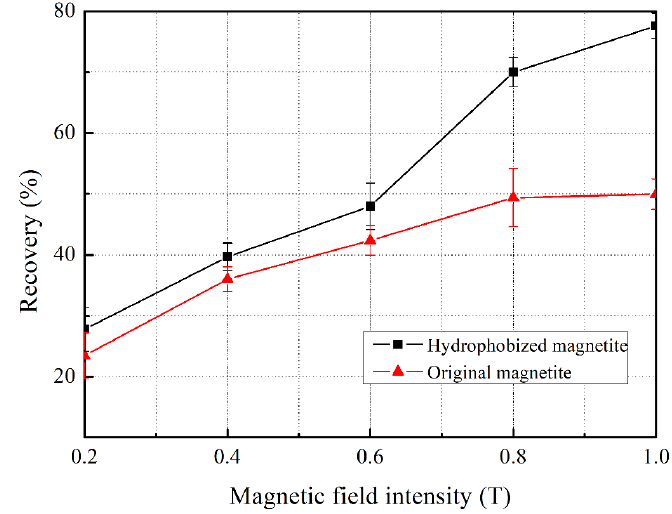
Figure 4. The recovery of microcrystalline graphite as a function of magnetic field intensity for two magnetic seeds. The error bars show the standard deviation of multiple replicates.